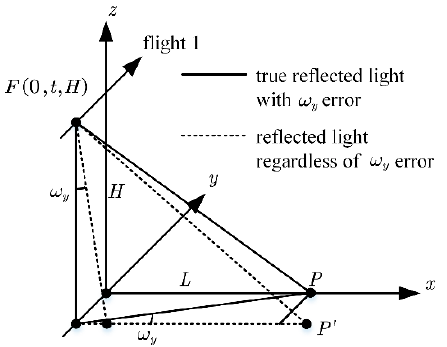
Figure 14. Schematic diagram of the simulation model of ω y .